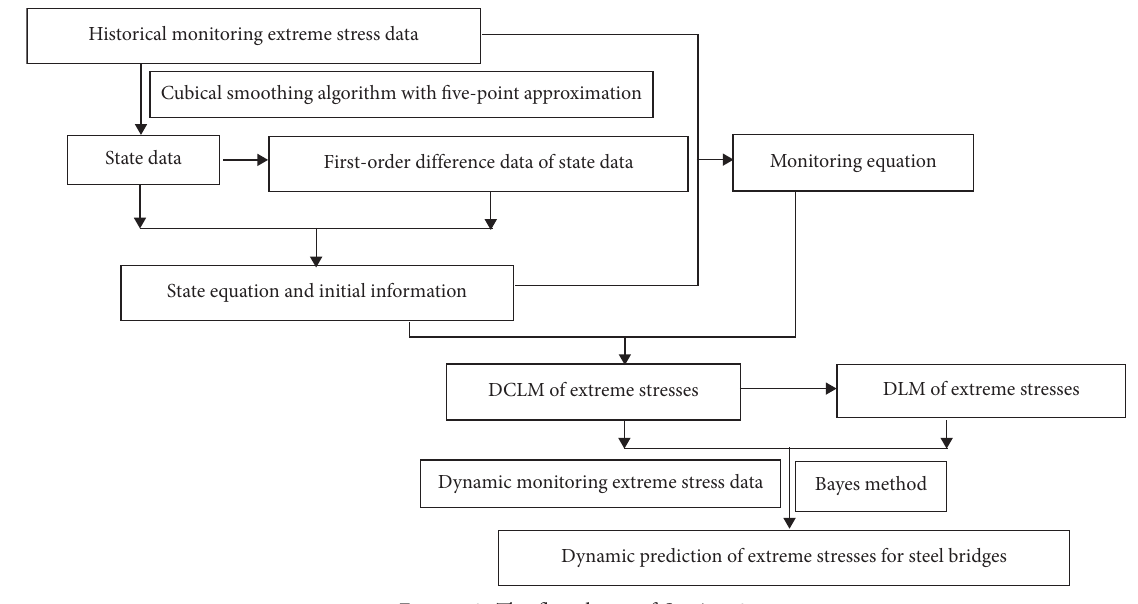
Figure 3: The flowcharts of Section